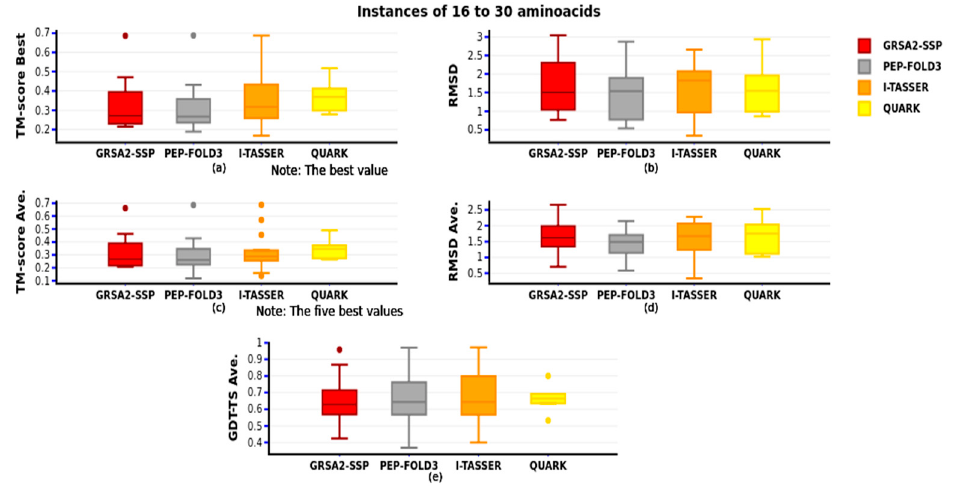
Figure 10. Comparison of GRSA2-TBM, PEP-FOLD3, and I-TASSER by TM-score (16 to 30 amino acids). Figure 10 ( a ) best TM-score, and ( b ) their RMSD, ( c ) TM-score average of the five best predictions, ( d ) RMSD of the five best predictions, and ( e ) GDT-TS average of the five best predictions.